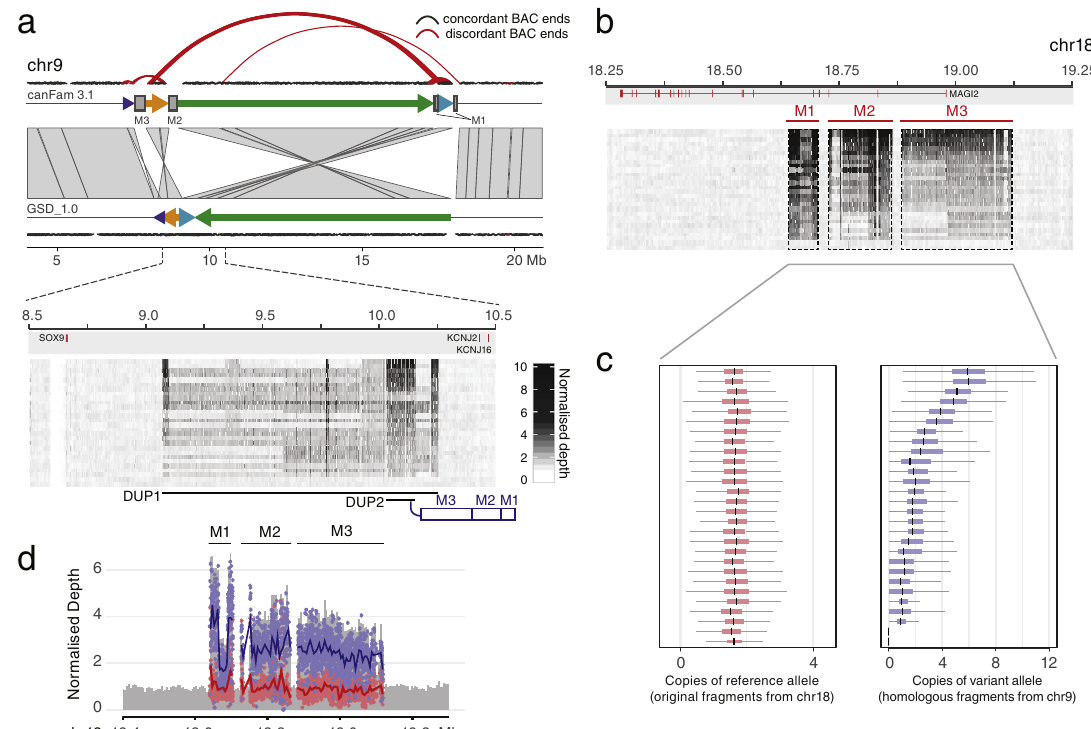
Fig. 4 Correction of an inverted region in chromosome 9. a Four fragments from the region were rearranged in GSD_1.0. The order was further con fi rmed using CanFam3.1 BAC clone (CH82) end sequences. Forty-nine discordant end pairs (red curves; >500 kb or not in a forward – reverse direction) were found at the edge of rearranged fragments in CanFam3.1, whereas these were properly mapped in GSD_1.0. From this region, three homologous chr 18 fragments spanning MAGI2 (M1, M2 and M3) were present on chr 9 of CanFam3.1, but missing in the GSD_1.0. We proposed that those homologous fragments should be located together with a duplication (DUP2, chr 9: 10.03 – 10.16 Mb) within a large duplicated region (DUP1, chr 9: 9.07 – 10.25 Mb). b Reads from both original and homologous M1, M2 and M3 fragments were mapped to chr 18 of GSD_1.0. c Mischka and all 10x dogs have only two original chr 18 copies M1, M2 and M3, but carry between 0 and 6 copies of the chr 9 homologous fragments. d The example plot of normalised depth illustrates how the copy number of the reference alleles and variant alleles were measured to distinguish the original (red) and homologous (blue) of M1, M2 and